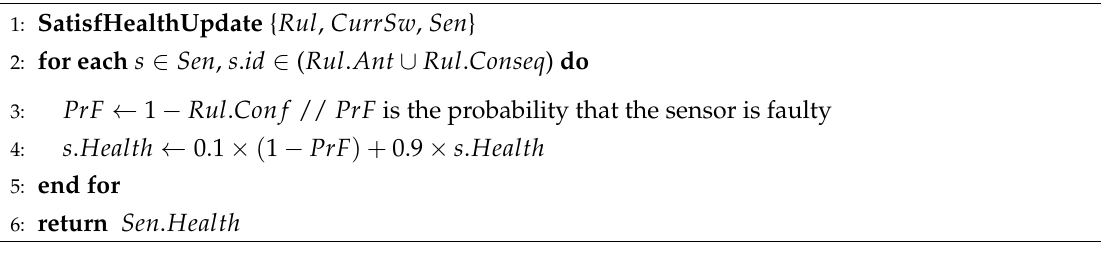
Algorithm A2 Health Status Update due to Rule Satisfaction.